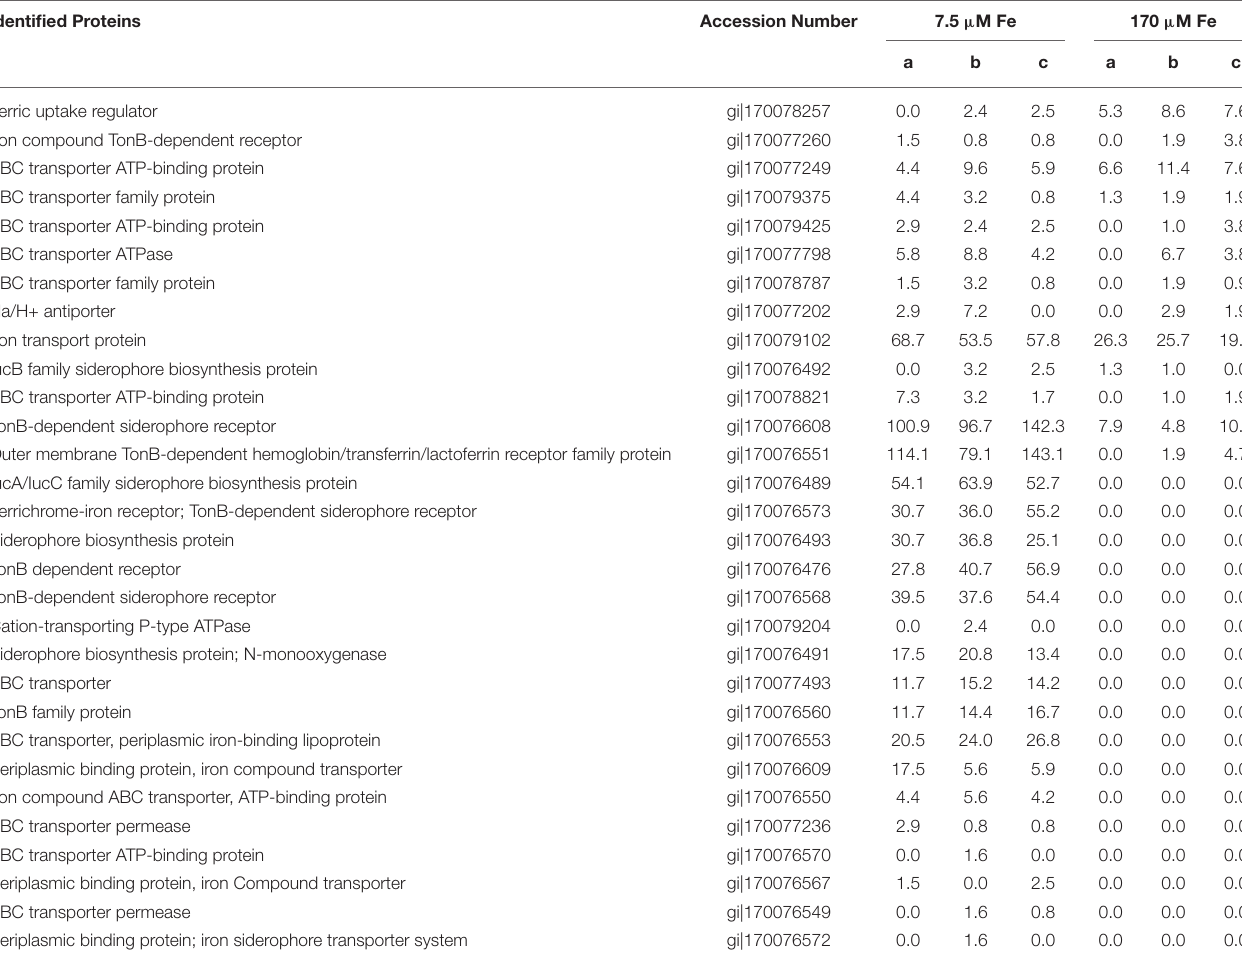
TABLE 4 | Proteins putatively involved in Fe uptake or siderophore biosynthesis and/or uptake in Synechococcus PCC 7002, and their spectral abundance under low Fe [7.5 µ m Fe(II)] or high Fe [170 µ m Fe(II)]. Identified